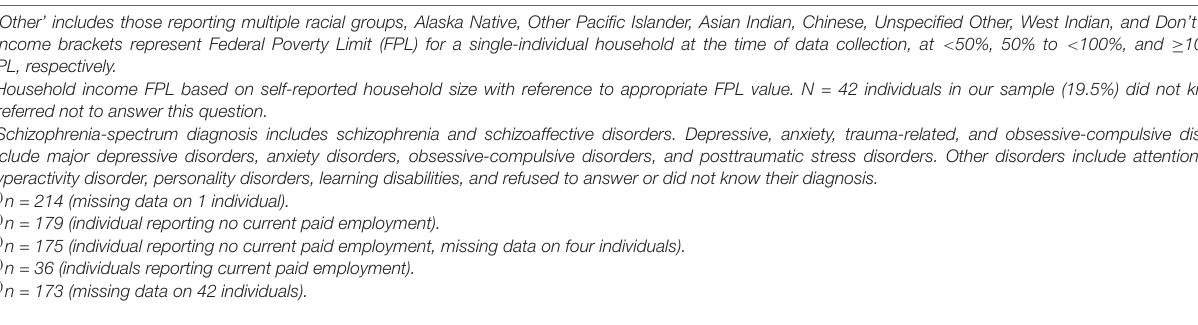
TABLE 2 | Descriptive statistics for independent and dependent variables and hypothesized mediators in a sample of people with psychiatric diagnoses in employment programs ( N = 215). Variable